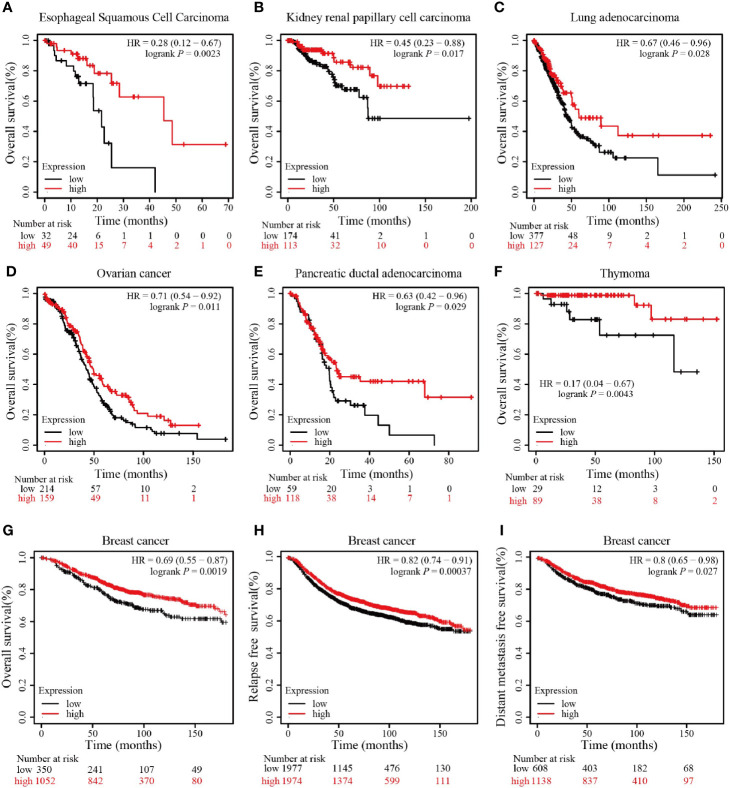
RING1 high expression is associated with better outcome. RING1 high expression is associated with better OS in ESCC (A), KIRP (B), LUAD (C), OV (D), PDAD (E), and THYM (F); RING1 high expression is associated with better OS (G), RFS (H), and DMFS (I) in breast cancer. All the above Kaplan–Meier survival curves were performed via the Kaplan–Meier plotter web tool. OS, overall survival; RFS, relapse free survival; DMFS, distant metastasis free survival; ESCC, esophageal squamous cell carcinoma; KIRP, kidney papillary cell carcinoma; LUAD, lung adenocarcinoma; OV, ovarian cancer; PDAD, pancreatic ductal adenocarcinoma; THYM, thymoma; HR, hazard ratio.